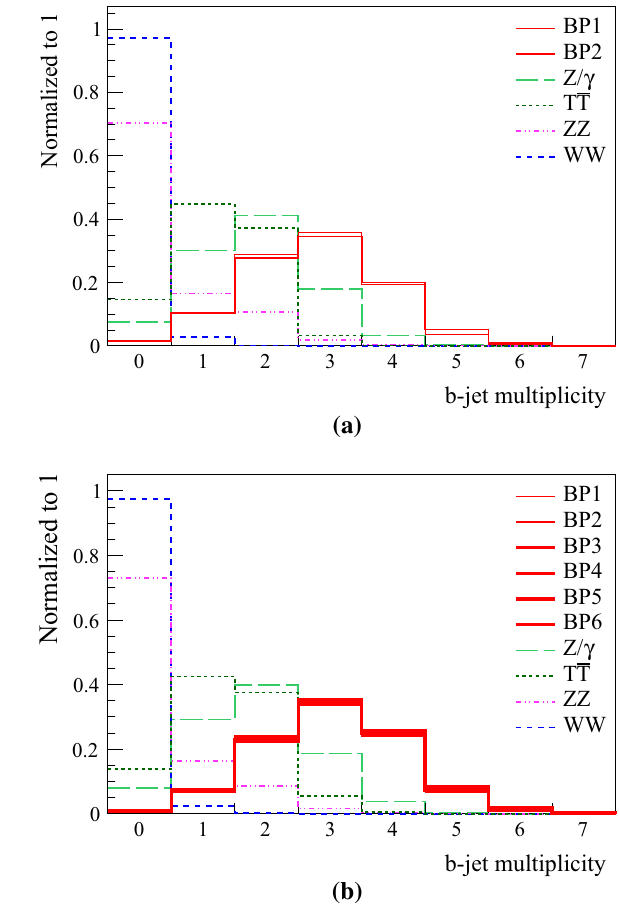
Fig. 2 Jet multiplicity distributions corresponding to different signal and background processes at the center-of-mass energies of a 500 and b 1000 GeV